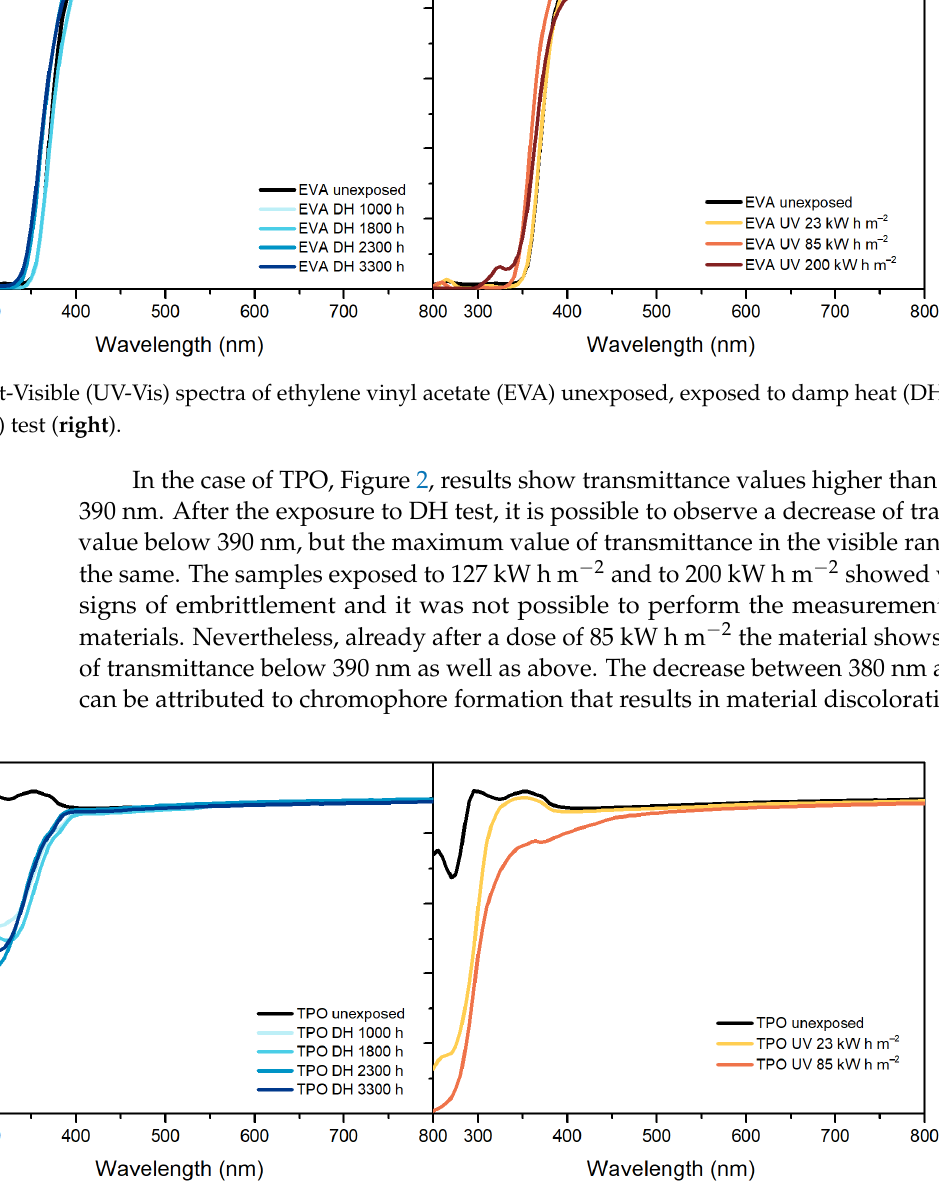
Figure 2. UV-Vis spectra of thermoplastic polyolefin (TPO) unexposed, exposed to DH (left) and UV test (right).